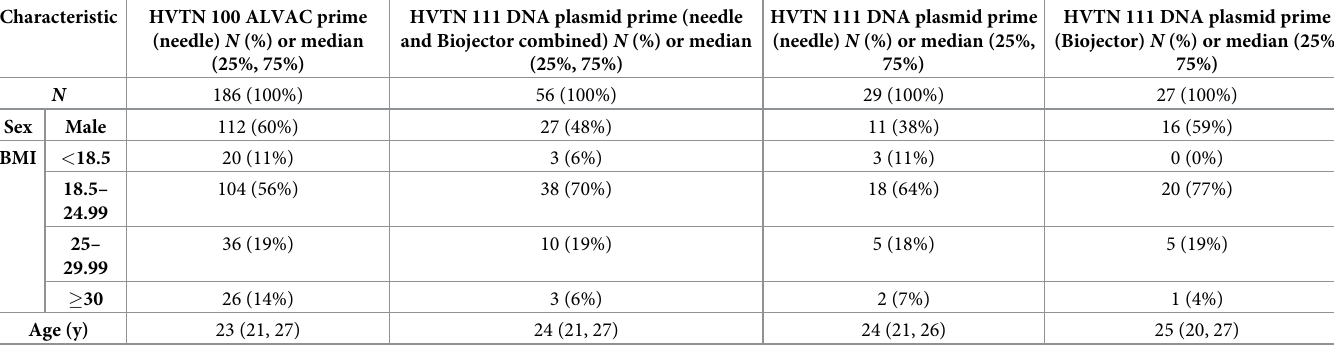
No significant differences among baseline characteristics between the study arms of each trial apart from a significantly higher proportion of men in the HVTN